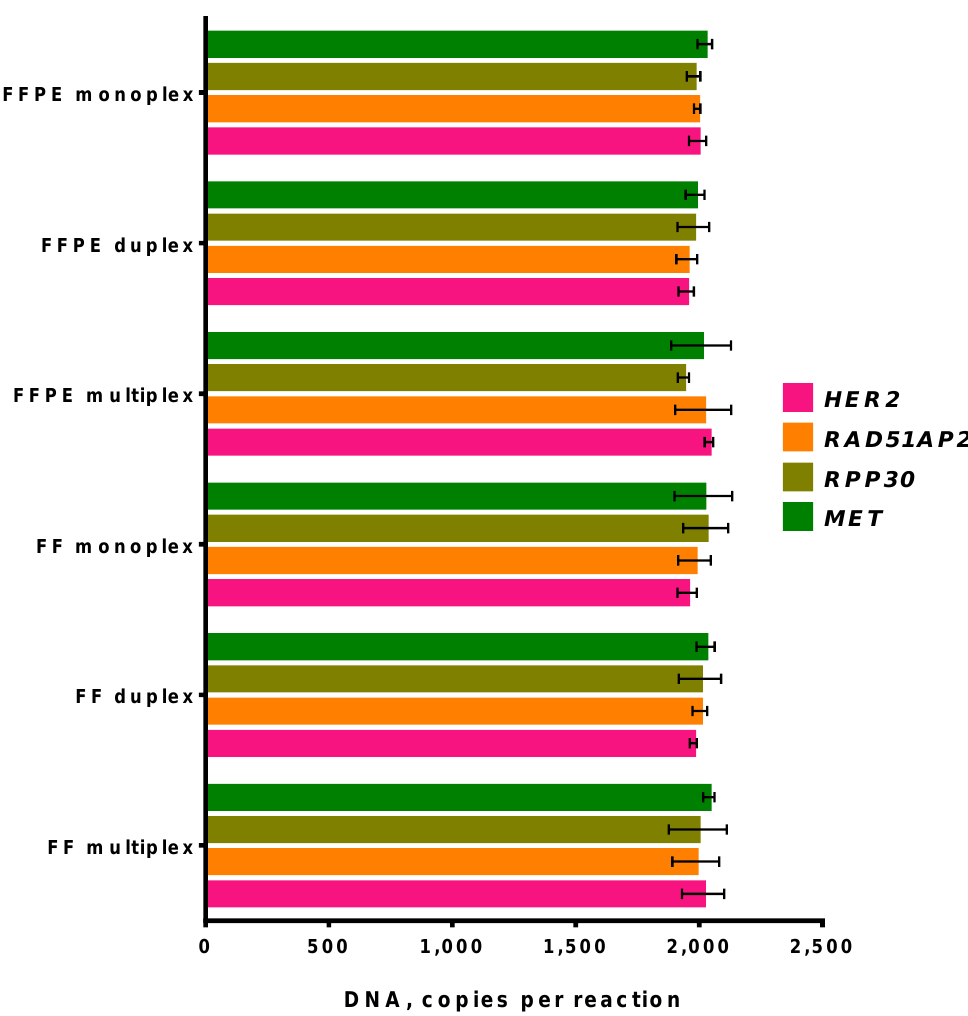
Figure 6. Influence of sample type on ddPCR performance. X-axis represents the concentration of genes; Y-axis shows the DNA sample and type of ddPCR—monoplex, duplex, or multiplex. FF—fresh-frozen, FFPE—formalin-fixed, paraffin-embedded samples. Whiskers designate standard deviation in two experiments.